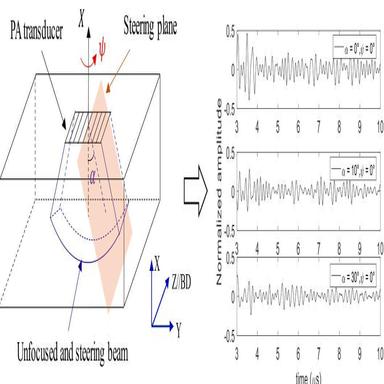
Schematic illustration of the PA backscattering method for anisotropy characterizations.